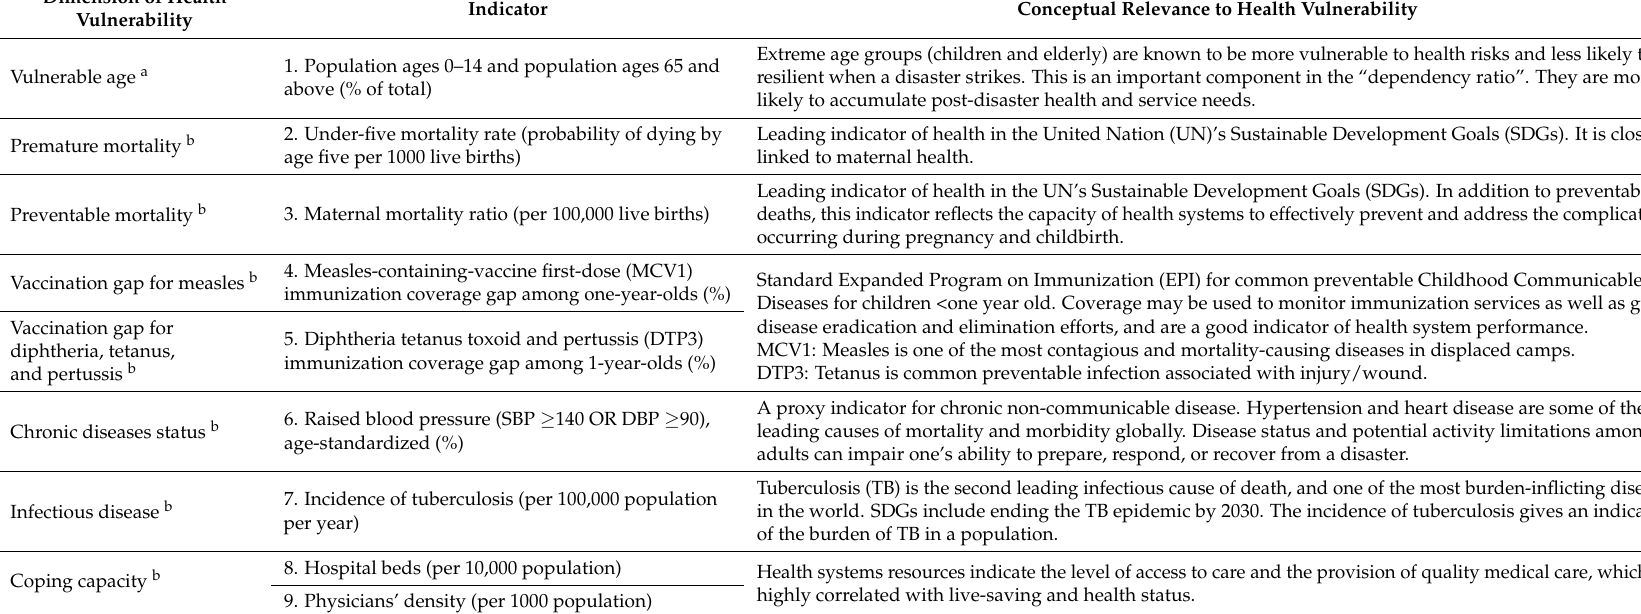
Table 1. Key indicators of health vulnerability and their